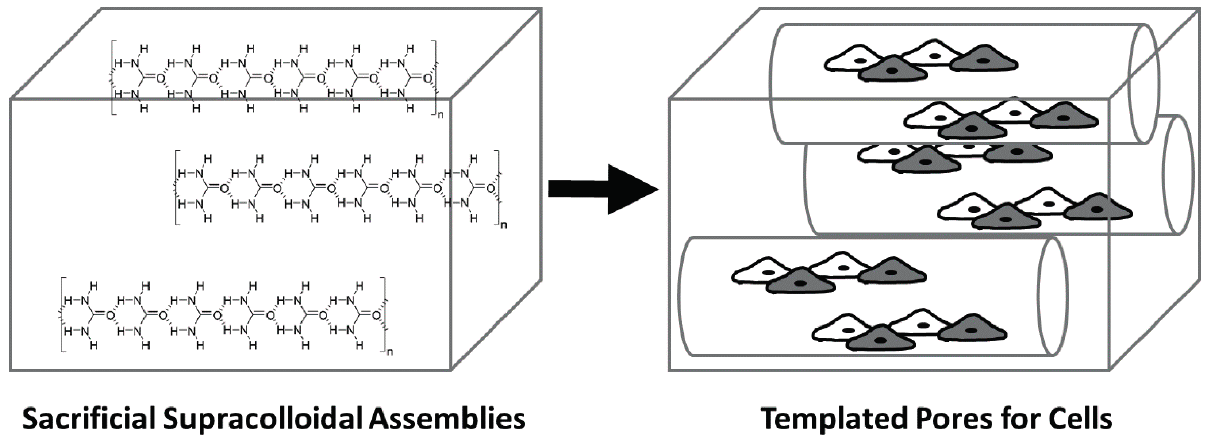
Figure 1. Hydrogen bond mediated self-assembly of supracolloidal assemblies of urea that act as sacrificial templates to impart pores in